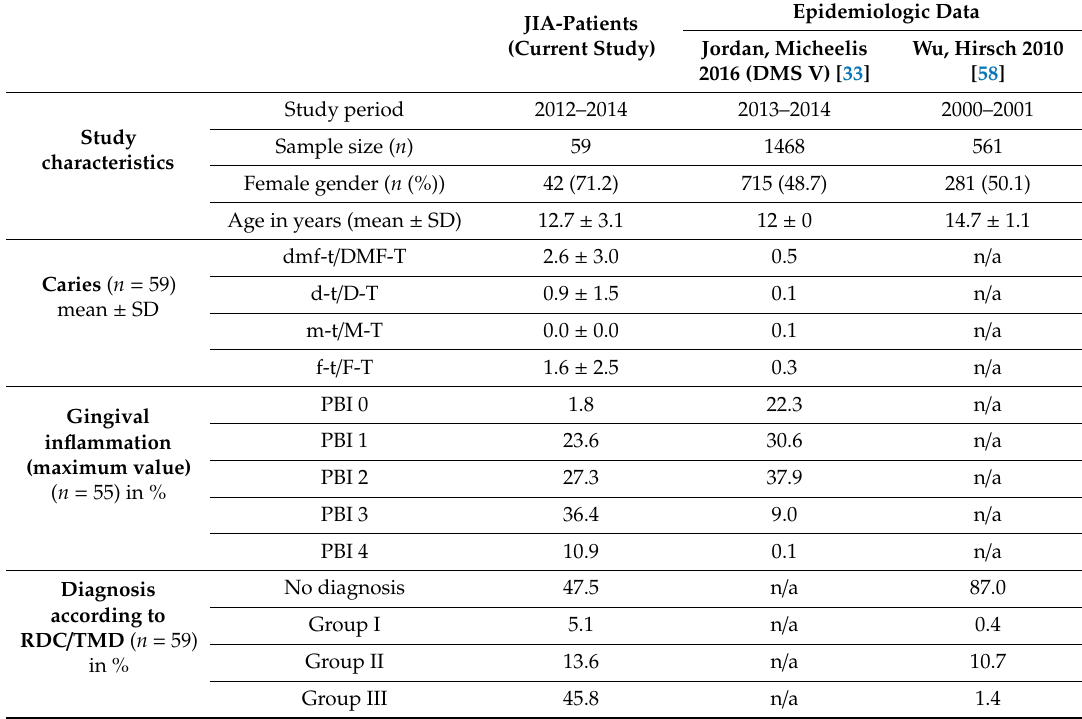
Table 4. Comparison of oral health parameters of JIA-patients of the current study to epidemiological